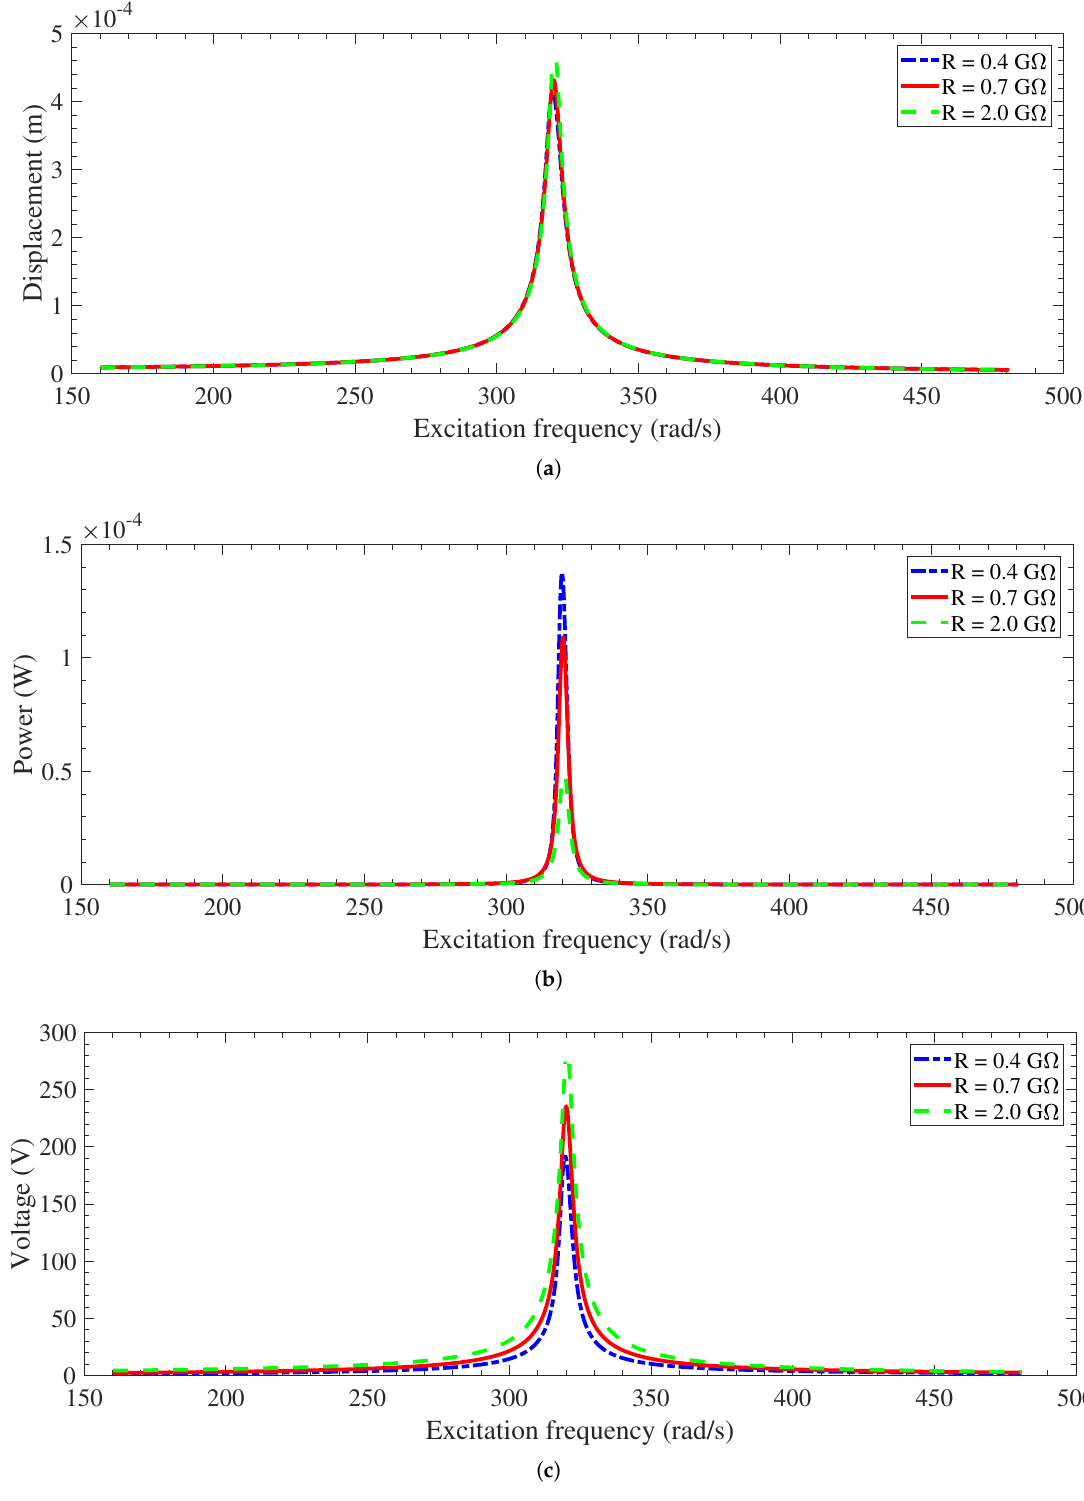
Figure 8. Frequency–response curves in terms of ( a ) displacement, ( b ) electrical harvested power, and ( c ) generated voltage for V et = 400